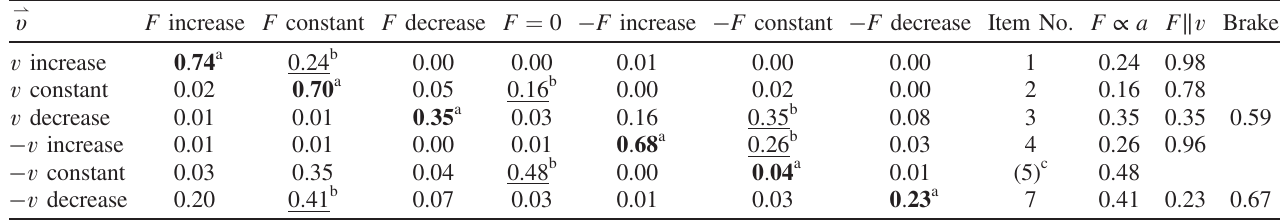
a The corresponding proportions of the F ∝ v model are shown in Table V in bold type. b The corresponding proportions of the F ∝ a model are shown in Table V in underlined type. c Item 5 is inaccurate for assessment, according to Ref.